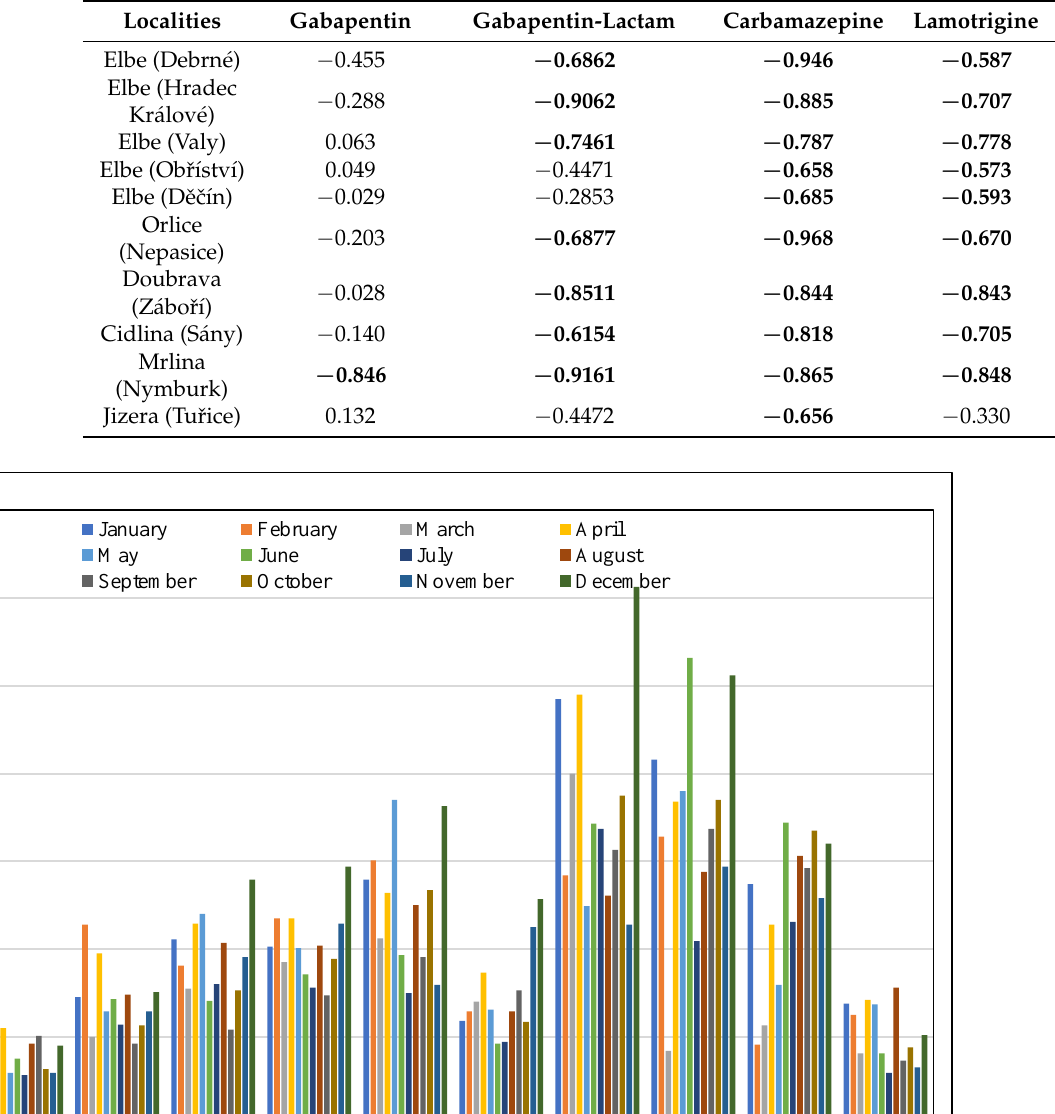
Table 2. Results of the Spearman’s rank-order correlation for concentrations of individual anticon- vulsive drugs and flow rate at monitored localities during the year 2021. The statistically significant Spearman ´ s rank coefficient ( p < 0.05) is indicated in boldface.